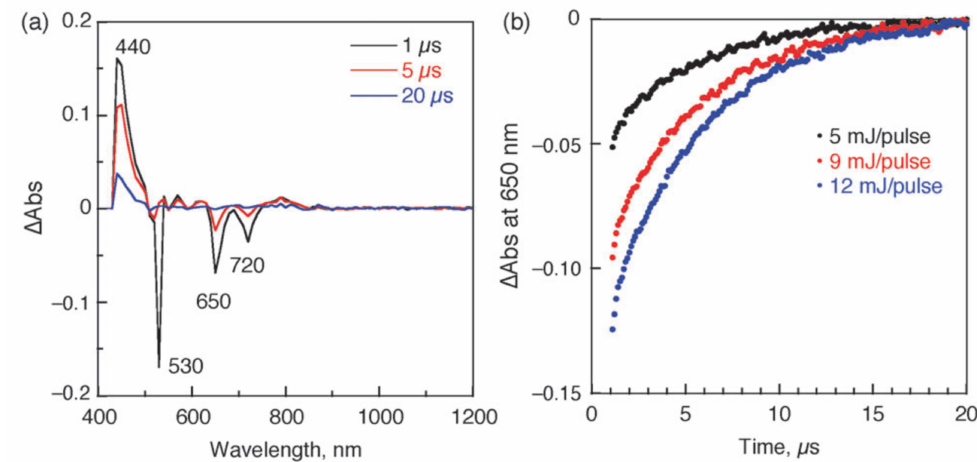
Figure 12. ( a ) Nanosecond flash photolysis absorption spectra for a mixture of porphyrin carboxylate (100 mM), 67 (100 mM), and Li + -C60 (100 mM) following excitation at 532 nm in deoxygenated PhCN at 298 K as recorded 1 ms (black), 5 ms (red), and 20 ms (blue) after laser pulse irradiation. ( b ) Decay time profiles of the absorbance at 650 nm obtained using various laser intensities